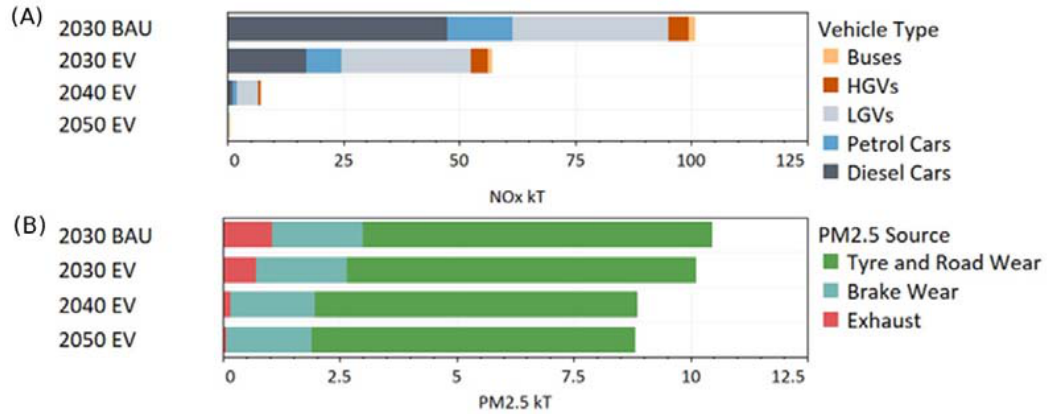
Figure 4. ( A ) Emissions of NOx from 2030 to 2050, where colour shows the emissions from each vehicle type. ( B ) PM2.5 Emissions from 2030 to 2050, where colour shows the emission source.